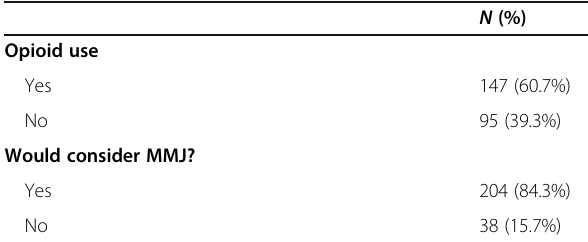
Table 1 Responses to questions 5 and 6: Current opioid use and willingness to consider medical marijuana among all respondents ( n =